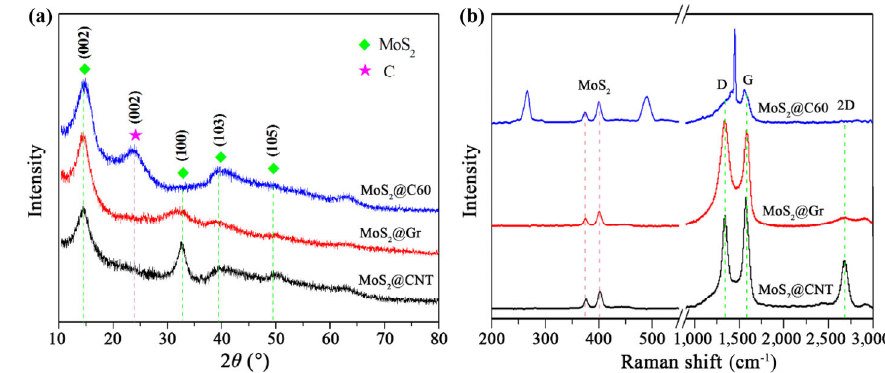
Fig. 2 (a) XRD and (b) Raman spectra of MoS 2 @CNT, MoS 2 @Gr, and MoS 2 @C60